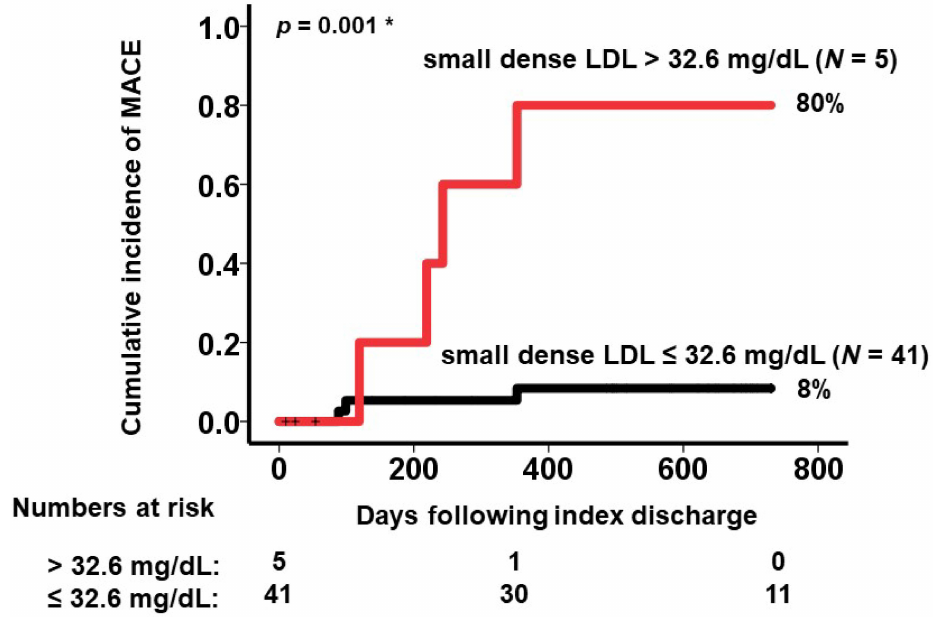
Figure 3. Cumulative incidence of MACE stratified by the level of small dense LDL cholesterol at index discharge. LDL, low-density lipoprotein; MACE, major adverse cardiac event. * p < 0.05 by log-rank